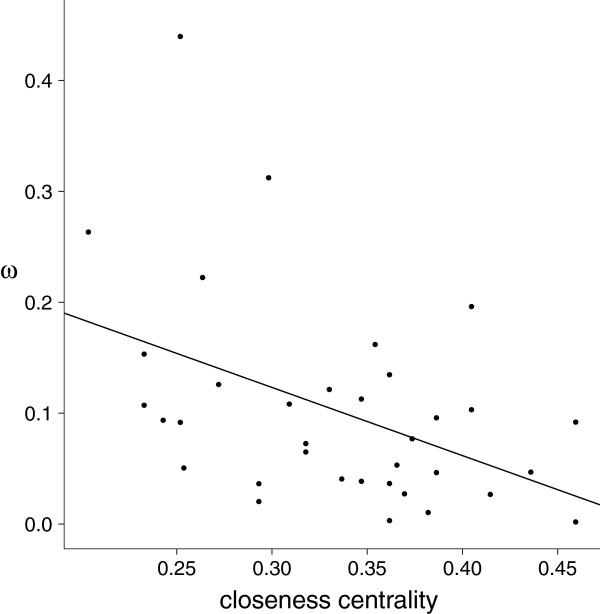
Distribution of selective pressures by network centrality. ω values compared to the closeness centralities of proteins in the network representation of the phototransduction signaling pathway. A least-squares regression line is shown (ρ=−0.4202, p=0.012).